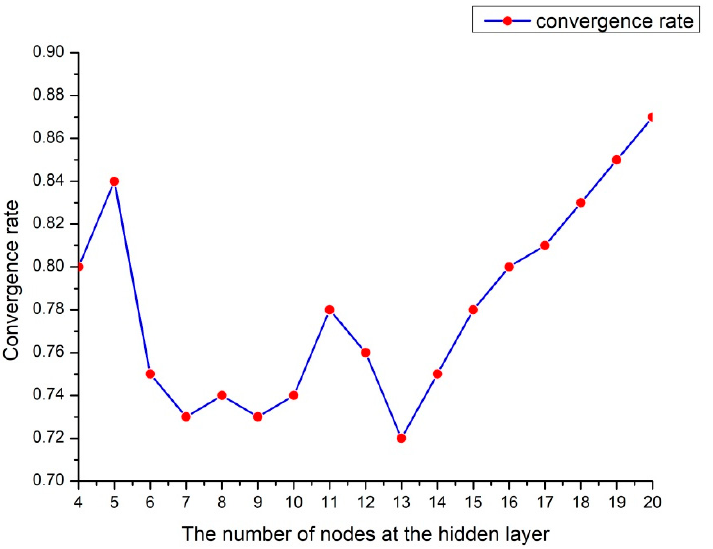
Figure 5. Relationship between sample convergence speed and the number of hidden layer nodes.